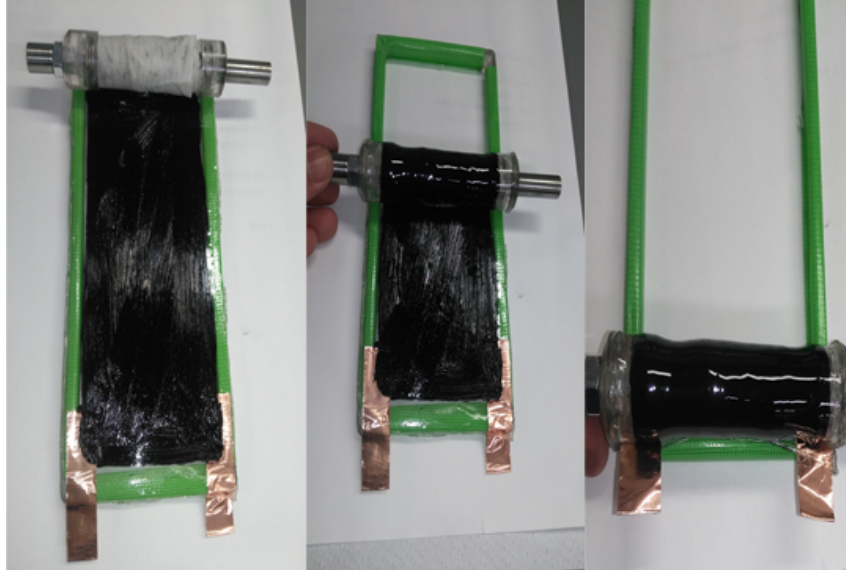
Figure 5. The DE actuator during the wrapping